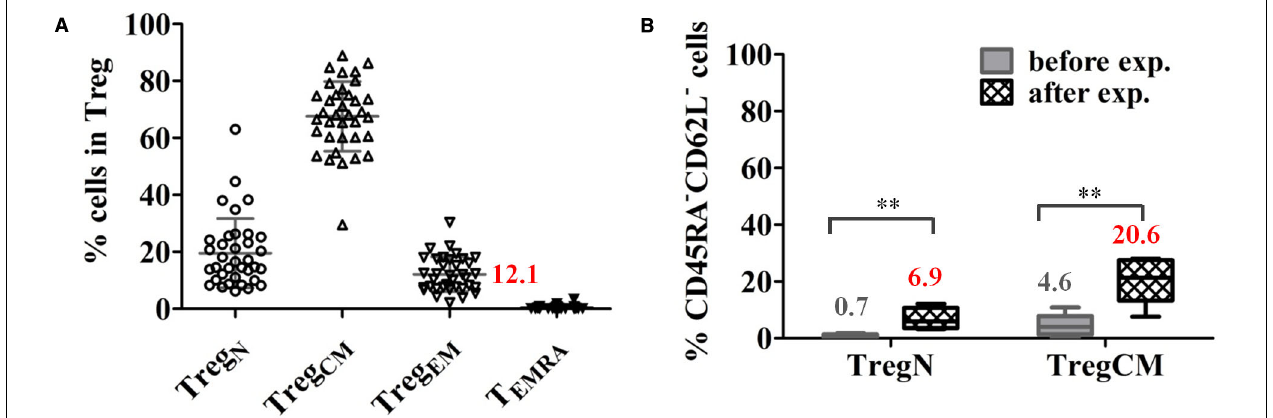
FIGURE 2 | A proportion of Treg express an effector-memory phenotype in healthy donors. (A) Proportions of Treg subsets in total Treg in healthy donors (mean (cid:6) SD, n = 36, age 19–87 years). (B) A significant proportion of expanded naïve (TregN) and central-memory Treg (TregCM) converted into EM (CD45RA (cid:0) CD62L (cid:0) ) phenotype upon 3 weeks of expansion with poly-clonal stimulation in the presence of rapamycin and interleukin 2. The mean frequency of cells expressing an EM phenotype is indicated for each cell type before and after expansion. ( n = 5), paired t -test, taken from Lei et al. (2015) ** p < 0.01.